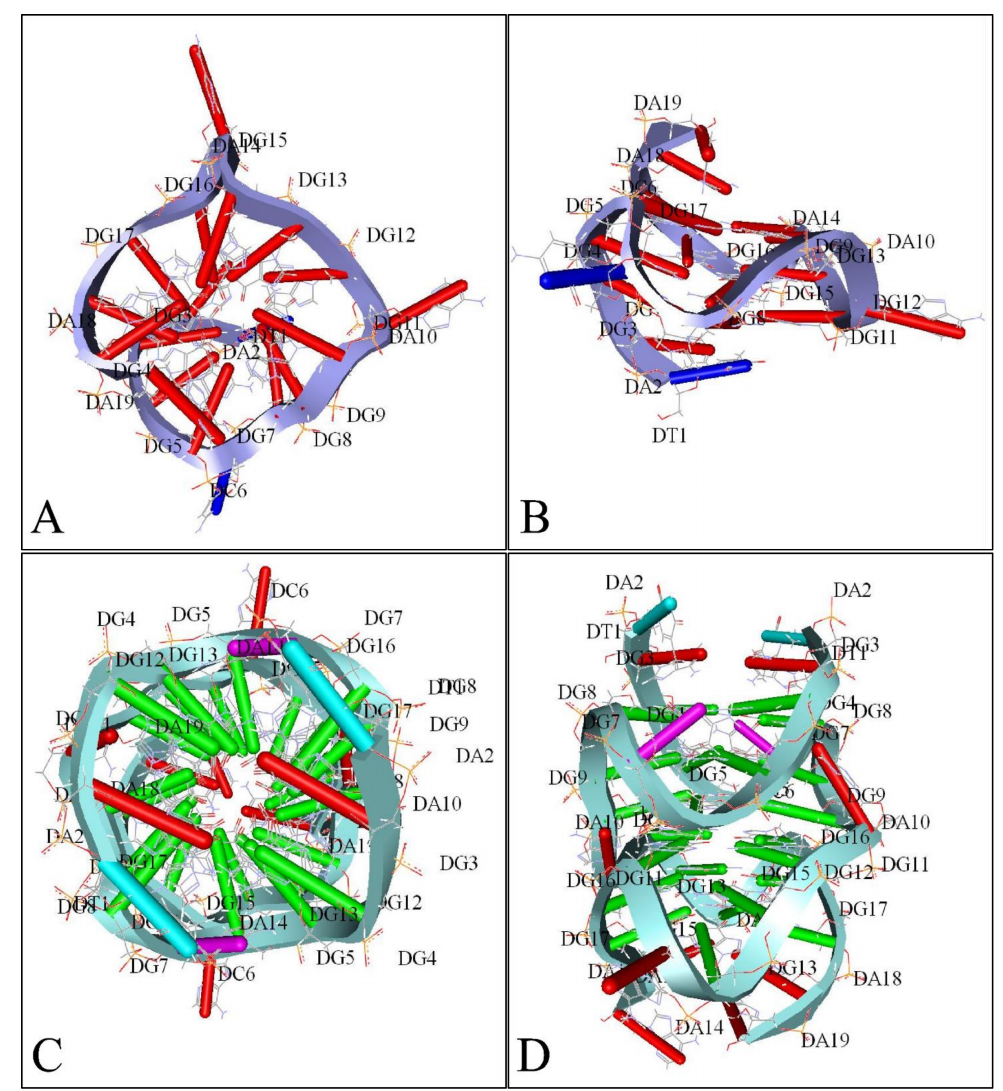
Figure 7. A 3D reconstruction of MYCN G-Quadraplexes. The transversal ( A ) and lateral ( B ) views of the 5 (cid:48) -T-A-G-G-G- C-G-G-G-A-G-G-G-A-G-G-G-A-A-3 (cid:48) nucleotide sequence’s G-quadraplex are presented as depicted from the deposited structure 2LEE (https://www.rcsb.org/structure/2LEE, accessed on 21 June 2021) in the Protein Data Bank (PDB)